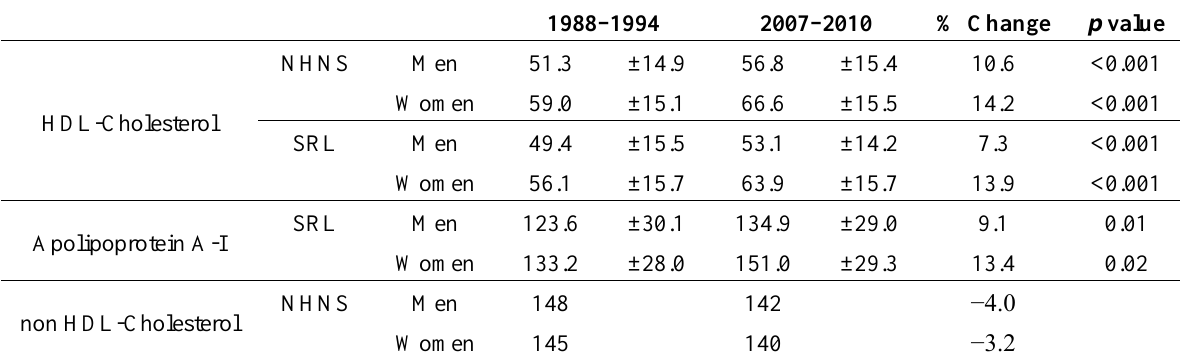
Table 1. Change of HDL and non-HDL in mg/dL, Mean ± SE, in the National Health and Nutrition Survey (NHNS) and SRL